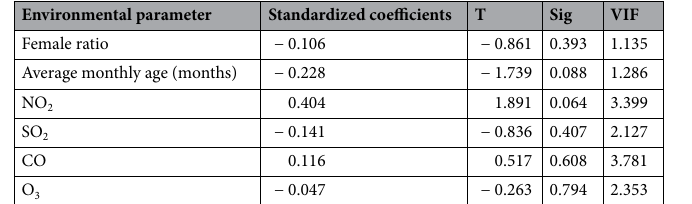
Environmental parameter